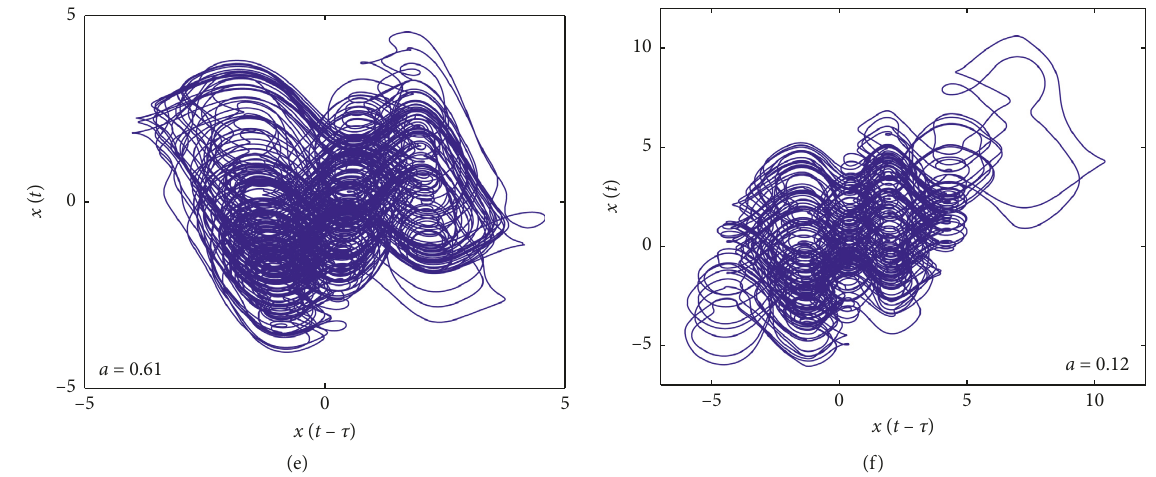
Figure 3: The initial condition is ϕ ( t ) � 1 for t ∈ [− τ , 0 ] throughout the investigation. Parameter b � 4, and time delay τ � 2. (a) Time series for a � 2 . 67, the fixed point is stable. Phase plane plots in ( x ( t − τ ) − x ( t )) plane for variable a , (b) period limit cycle for a � 2 . 35, (c) chaotic attractor for a � 2 . 02, (d and e) hyperchaotic attractor for a � 1 . 57 and a � 0 . 61, (f) multiscroll hyperchaotic attractor for a � 0 . 12.